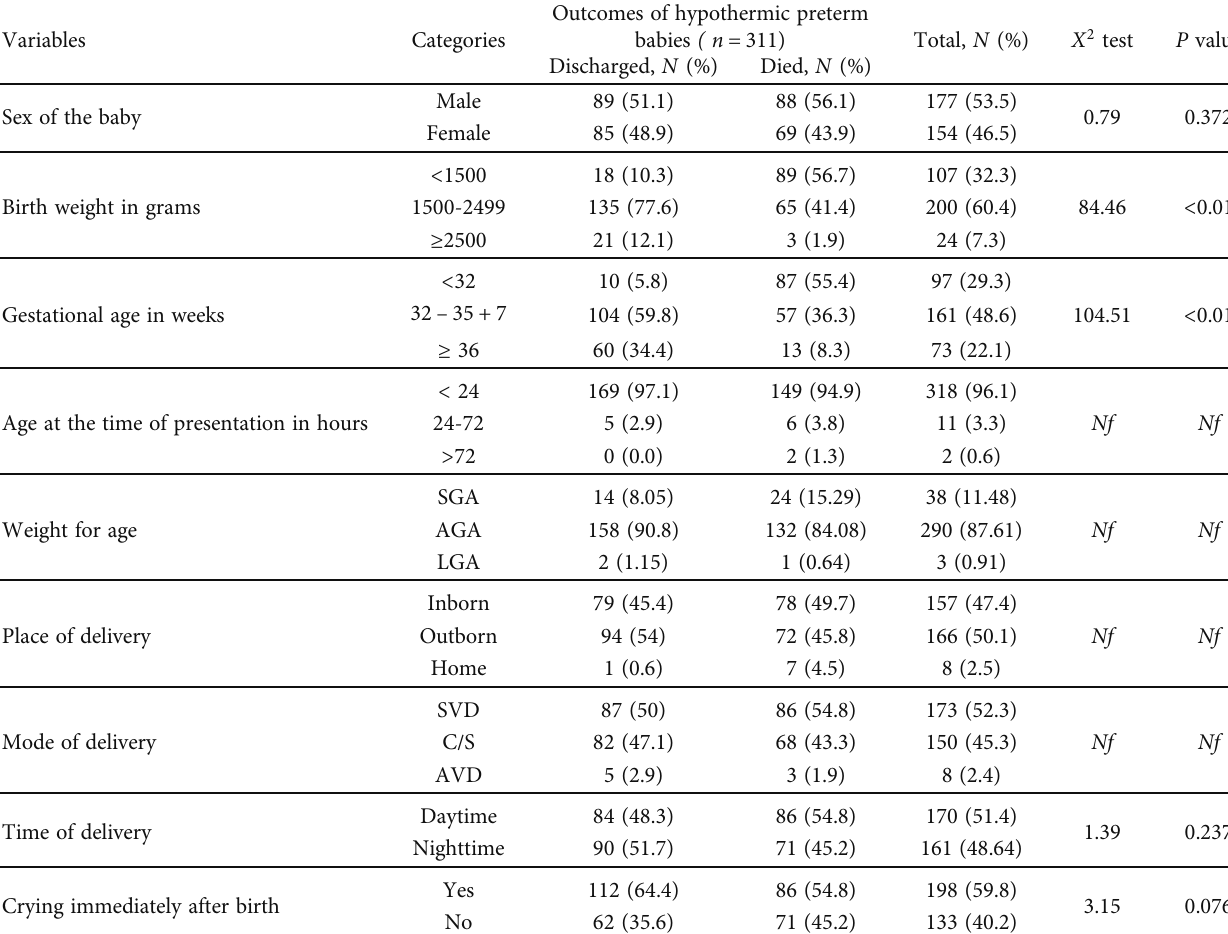
Table 1: Cross-tabulation showing the preterm neonate and obstetrics characteristics with outcomes of hypothermic preterm babies in Addis Ababa public hospitals,